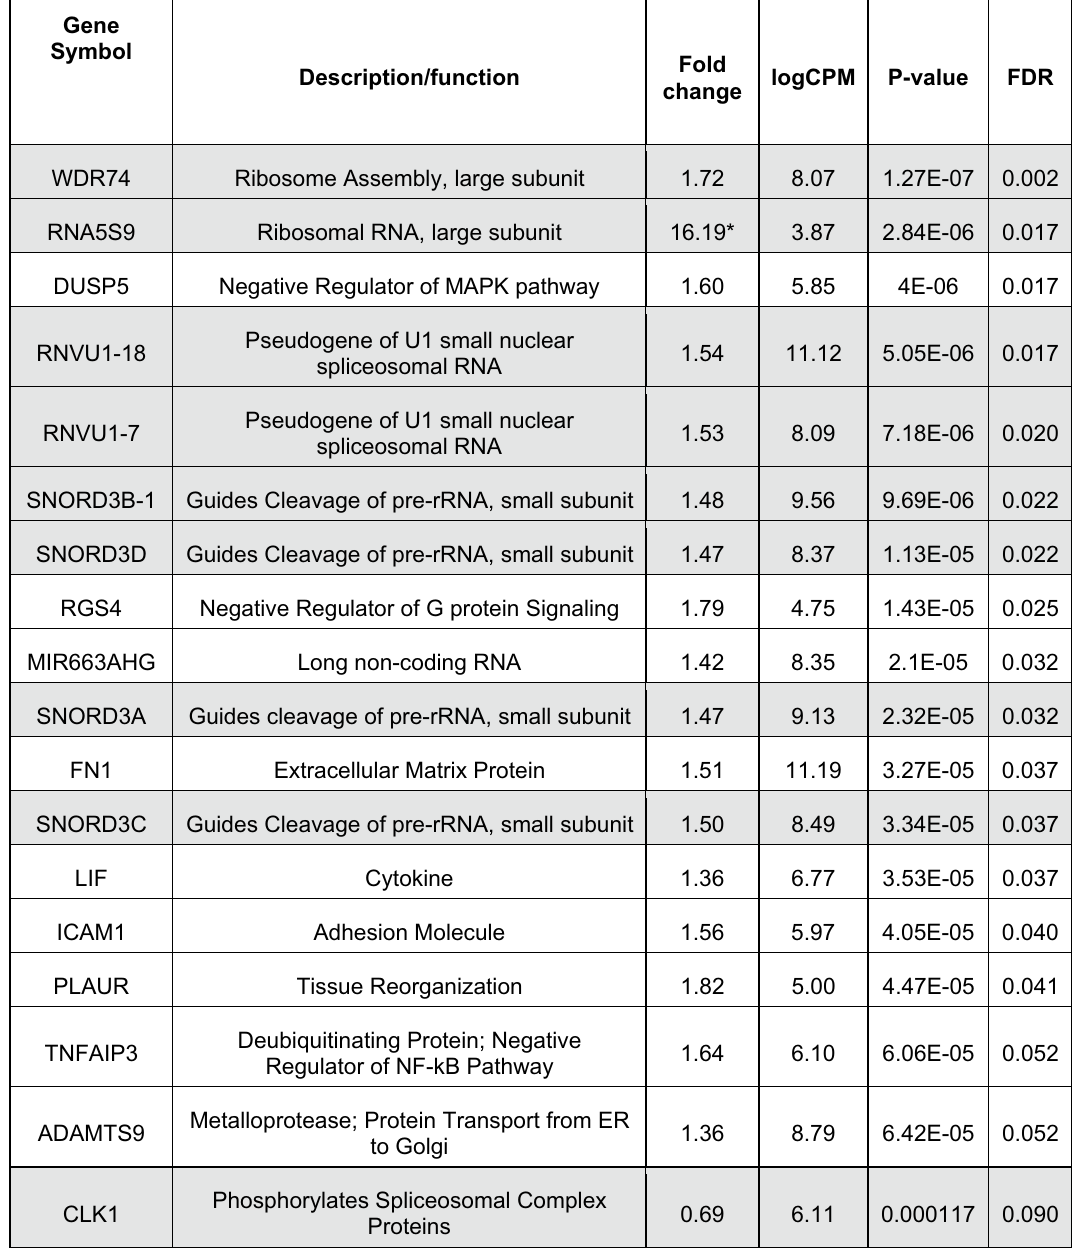
Table 3. Transcriptional response of PTECs in PT-MPS to DSP PSO treatment. Shaded rows depict genes that have functions related to nucleoprotein activity; log counts per million reads (LogCPM) is the average expression level for each gene across all samples; false discovery rate